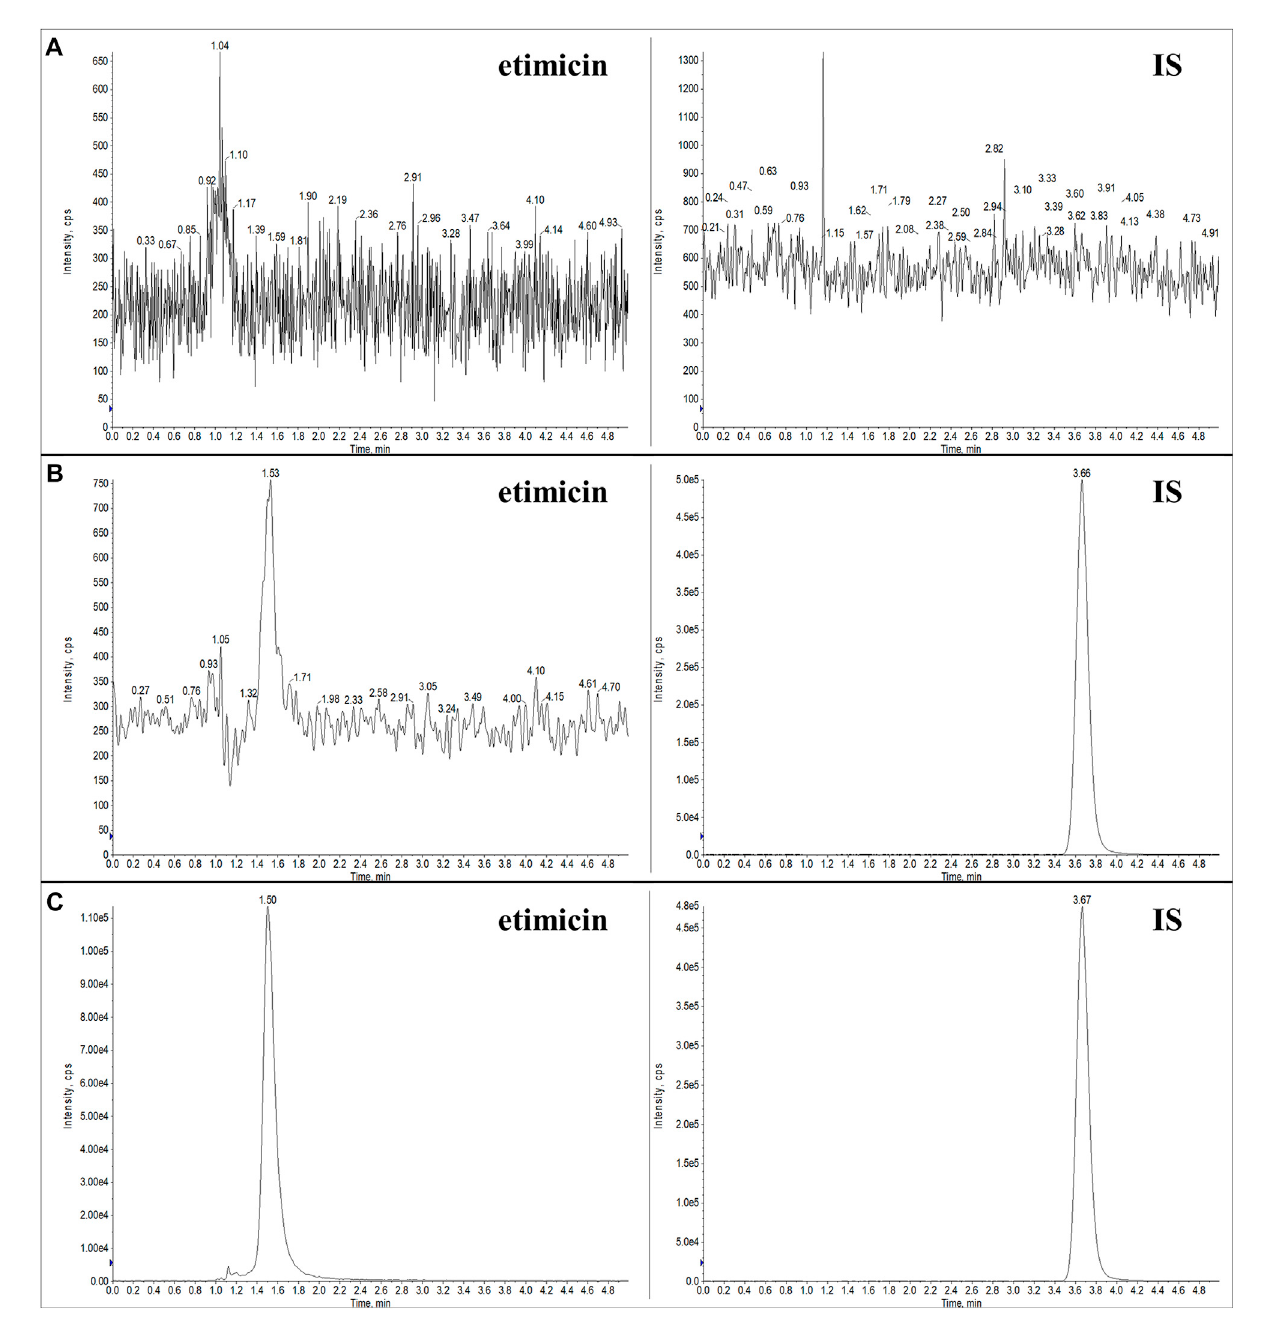
FIGURE 3 Representative LC-MS/MS chromatograms of etimicin and the IS in blank serum (A) , LLOQ serum (B) , and serum sample from Chinese HVs after administration of etimicin (C) . Transitions monitored for quantitation were m/z 478.280 → 191.110 for etimicin and m/z 247.100 → 204.197 for the IS,